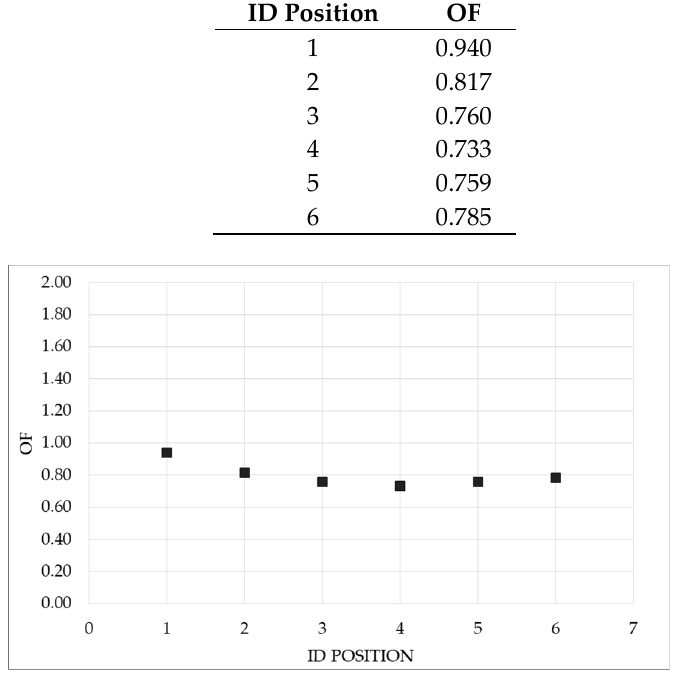
Figure 5. OF values for different position of additional